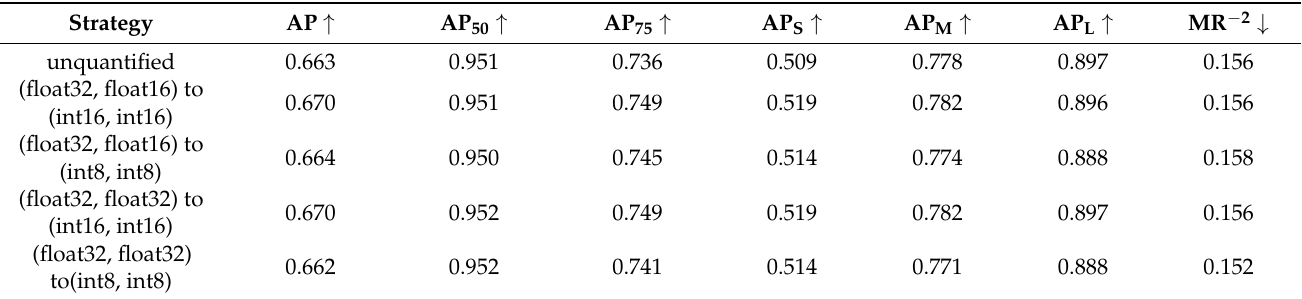
Table 6. Effects of different quantization degrees on the method’s accuracy. In the first column, the first value in the first parentheses represents the numerical type of the weight, and the second value in the first parentheses represents the numerical type of the input. “to” represents converting the numeric type in the first parenthesis to int8 or int16. “ ↑ ” indicates that the larger the value, the better the performance; “ ↓ ” indicates that the smaller the value, the better the